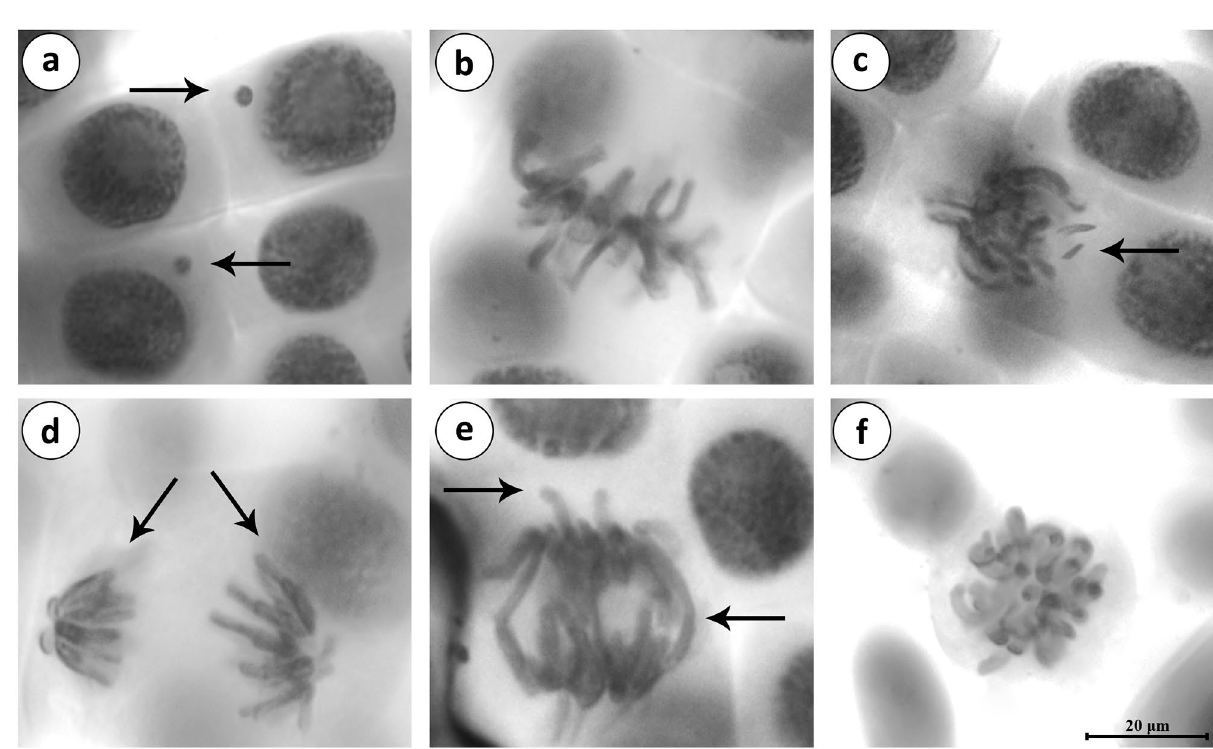
Figure 3. CAs and MN formations induced by penoxsulam ( a MN, b sticky chromosome, c fragment, d unequal distribution of chromatin, e bridge and vagrant chromosome, f c-mitosis. Scale bar = 20